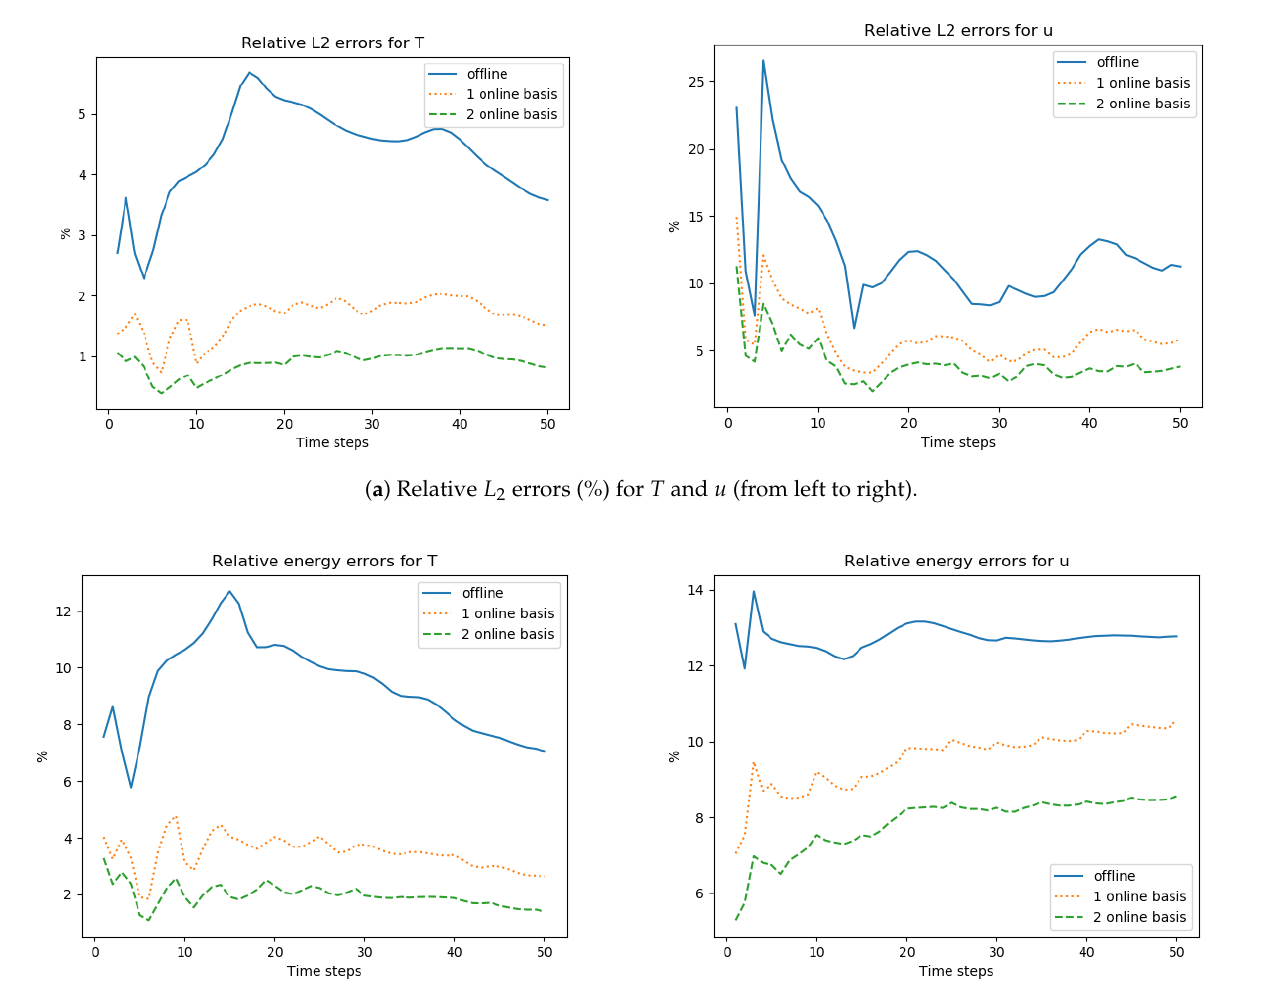
Figure 12. Relative L 2 and energy errors (%) for multiscale solutions using 4 offline basis functions and 1 and 2 online basis functions (enrichment periodicity is